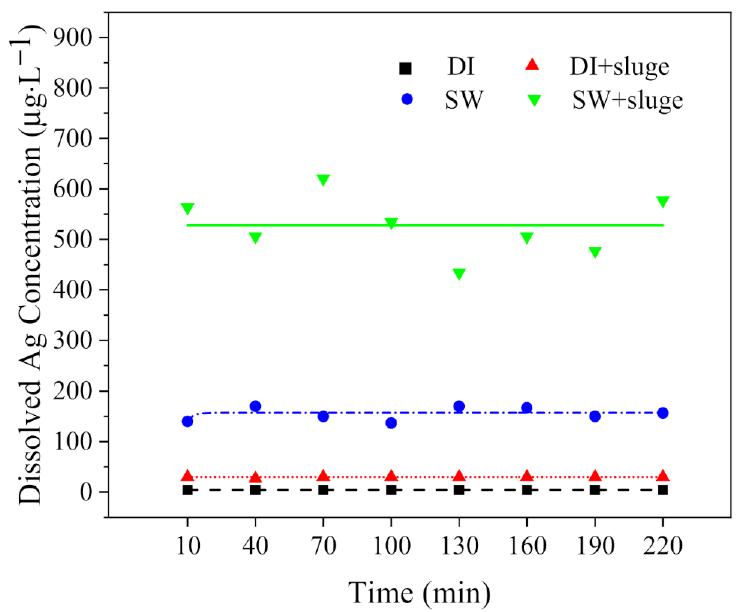
Figure 7. The effect of exposure time on the dissolved Ag after exposing cit − AgNPs (50 × dilution, 1.7 × 10 10 particles ml − 1 , 1.68 mg L − 1 ) in DI and SW, with or without sludge, respectively. Notes: pH and IS in SW was 8.7 and 100 mM, respectively. HA in sludge was 42 mg L − 1